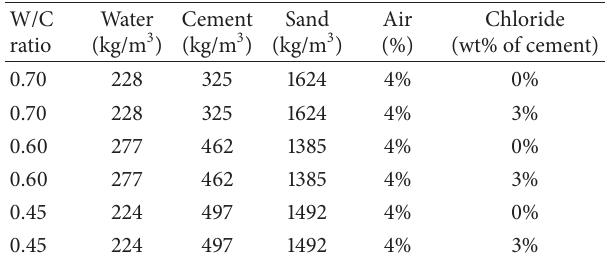
Table 1: Mix proportion of mortars used in this